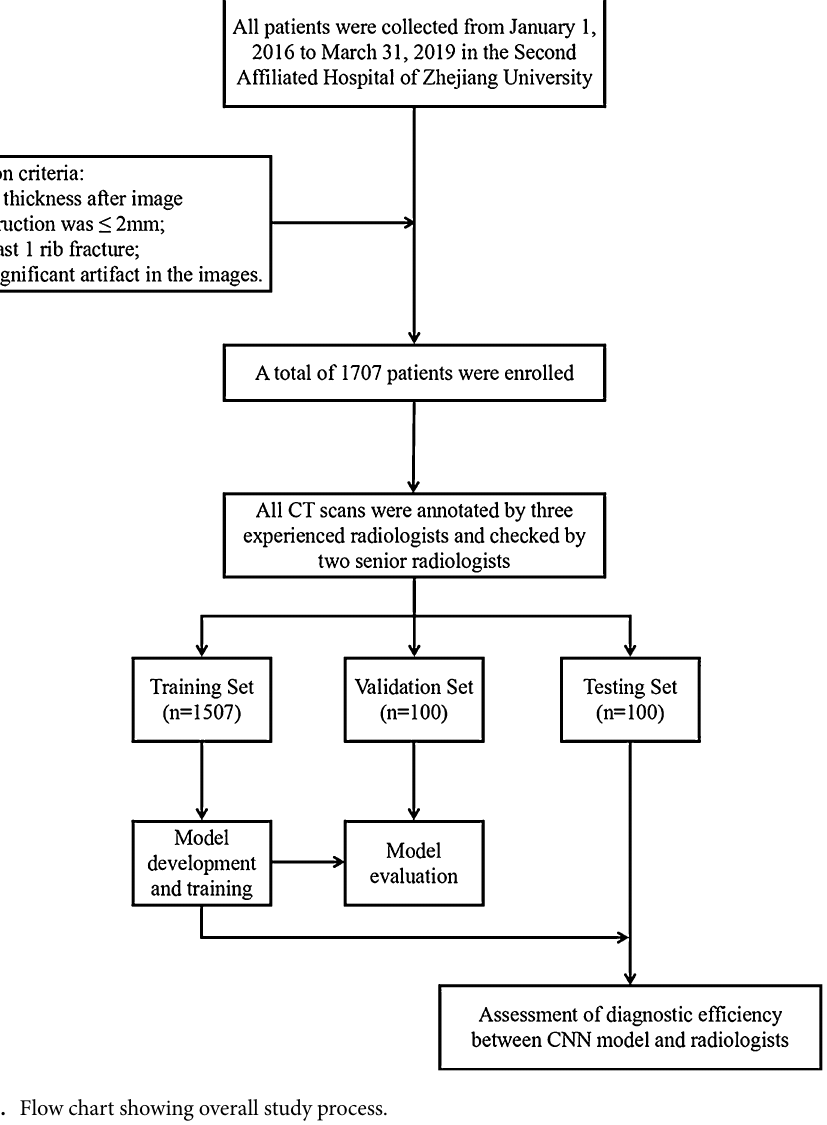
Figure 1. Flow chart showing overall study process.